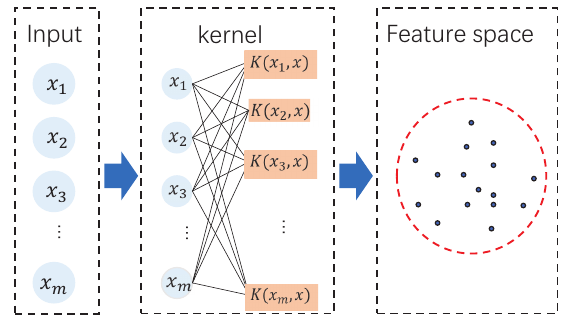
Figure 1. Support vector data description (SVDD)